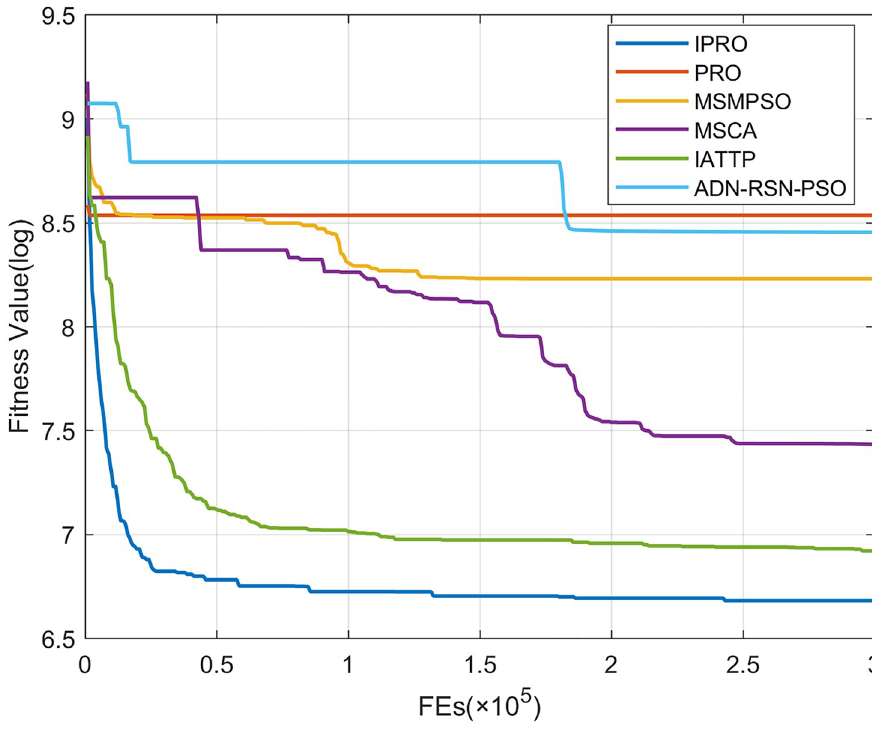
Fig 28. Convergence curves on F28.